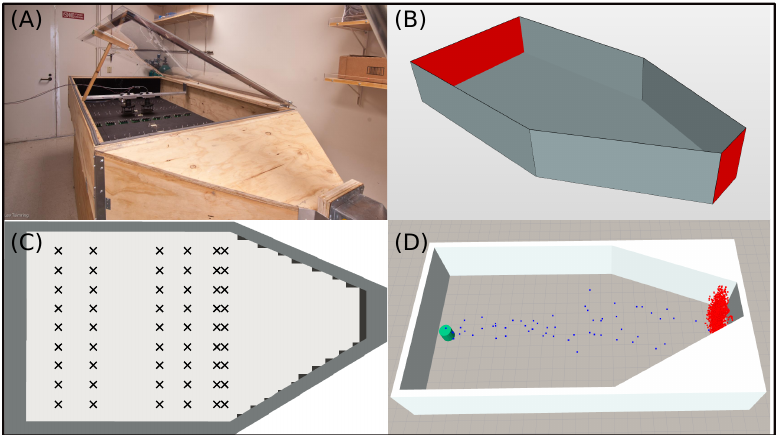
Figure 7. The wind tunnel test-bed facility: ( A ) picture of the physical wind tunnel used to collect the dataset (Image courtesy of Jordi Fonollosa), ( B ) illustration of the CAD model used during simulation (red faces corresponds to the wind inlet/outlet), ( C ) schema of the 54 e-nose locations used along the dataset, and ( D ) snapshot of a simulated gas plume (blue dots represents active filaments, while red dots are filaments that already passed through the